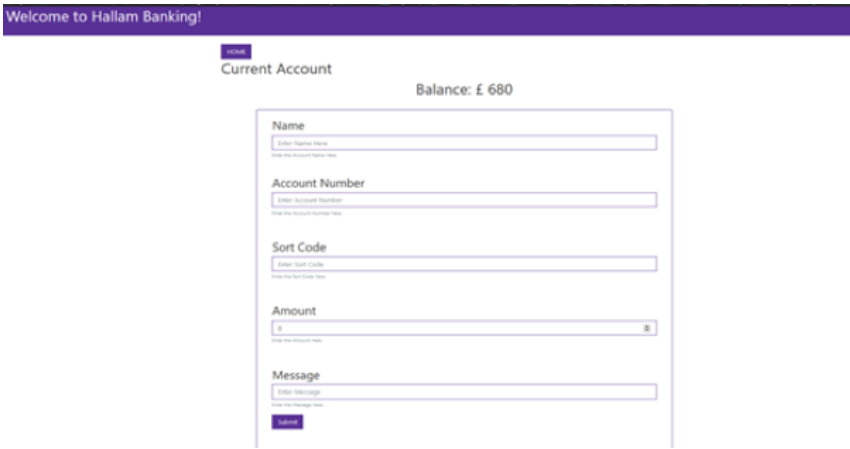
Figure 5. A screenshot of the money transfer page of our flat